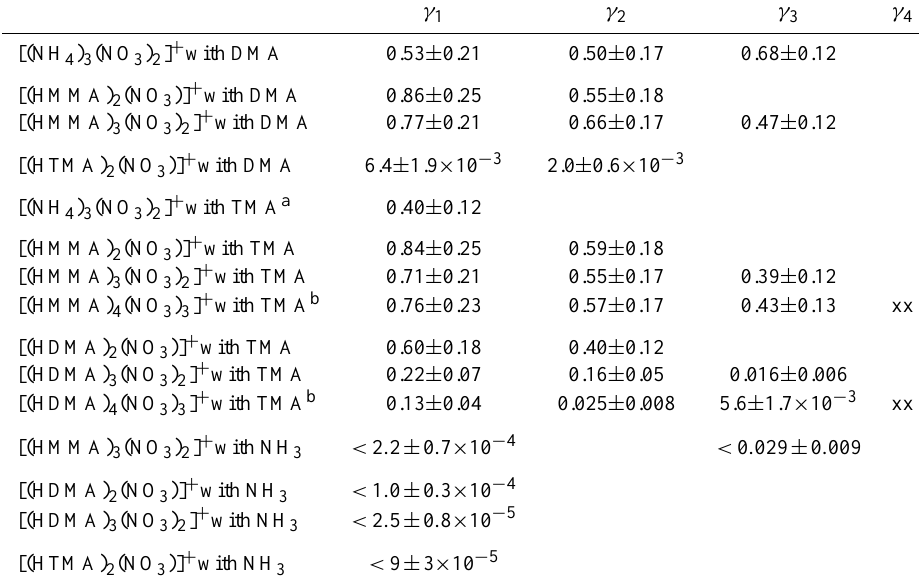
Table 6. Uptake coefficients for the substitution reactions of nitrate